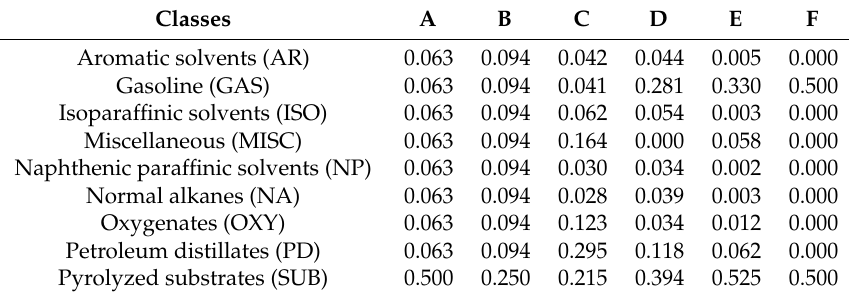
Table 1. Population distributions used to create model distribution data sets in this study: ( A ) Uniform across samples containing ignitable liquid residue (IL) classes and balanced total IL and samples that do not contain ignitable liquid residue (SUB) contributions. ( B ) Uniform across IL classes and unbalanced total IL and SUB contributions. ( C ) Distribution of IL classes in the Ignitable Liquids Reference Collection, and Substrates databases. ( D ) Distribution of IL classes and SUB from large scale burns previously reported in [7]. ( E ) Distribution of IL classes and SUB determinations from 70,000 cases over 10 years, as previously reported in [7]. ( F ) Balanced IL and SUB with only gasoline contributing to the distribution of IL